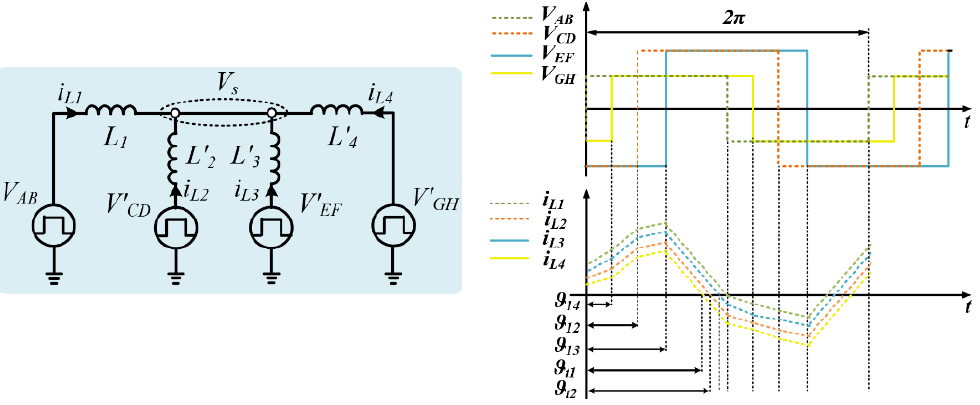
Figure 8. Multi-port bidirectional dual active bridge converter.